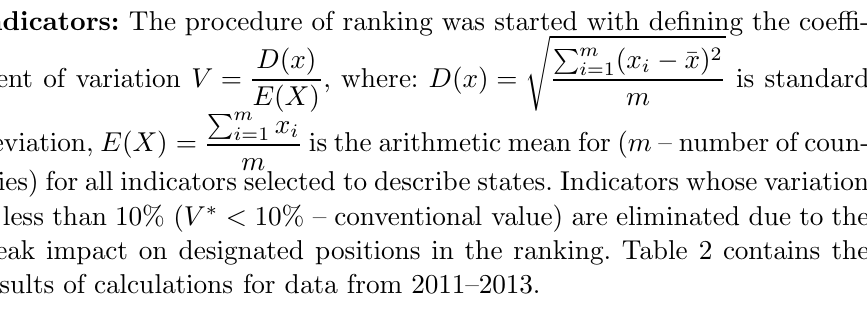
Indicators of stratification and poverty The ratio of the income of the The share of highest decile income of the Gini Taxes for group to the highest decile coefficient the richest income of the group in total lowest decile income group